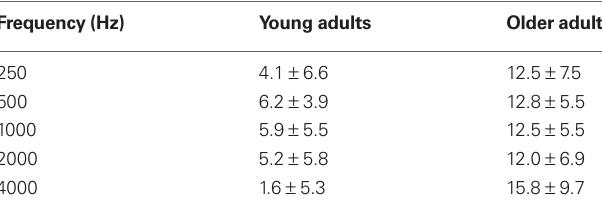
Table 1 | Audiometric data for participants in the adaptation